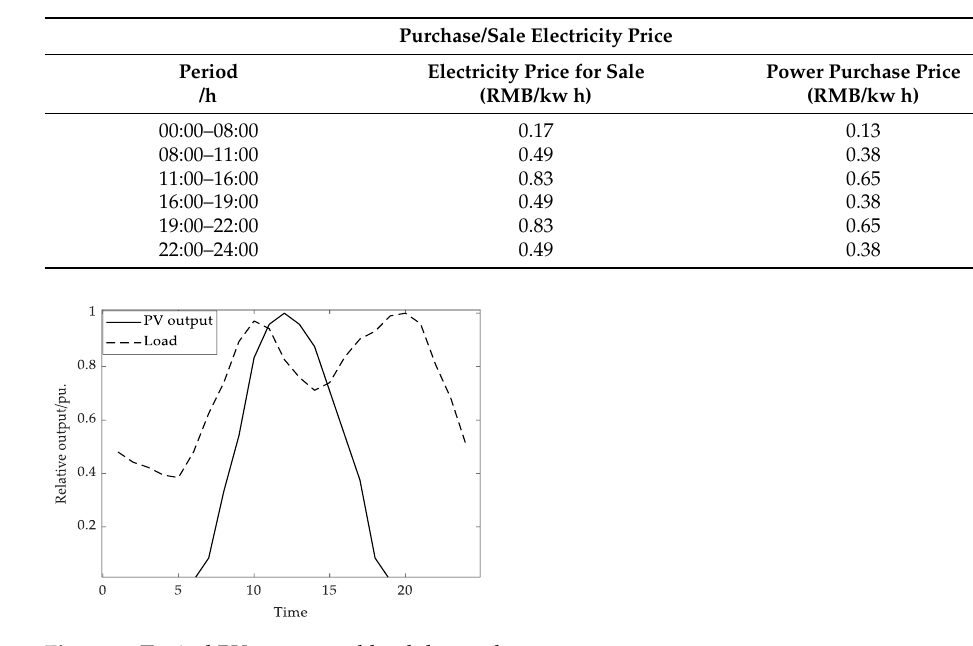
Figure 6. Typical PV output and load demand curve. Table 1. Time of use power price.